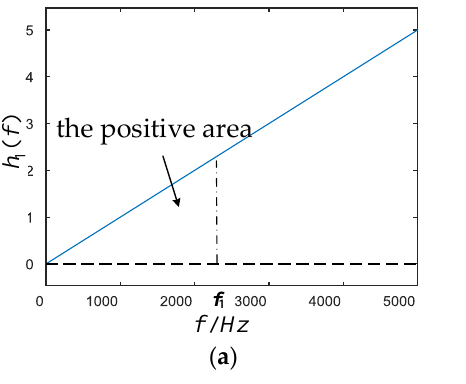
Figure 9. The curves of h 1 ( f ) and h 2 ( f ): ( a ) h 1 ( f ); ( b ) h 2 ( f ).